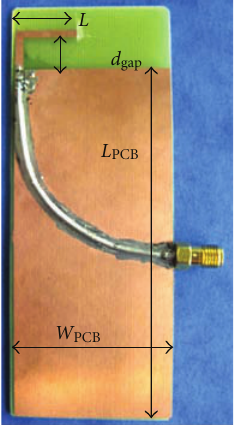
F21:Comparisonsofthemeasuredaverageantennaefficiency MHz in free space and regarding hand loading for the proposed antenna systems depicted in Figure 19 and regarding the ( 824 ) three positions of the �nger.